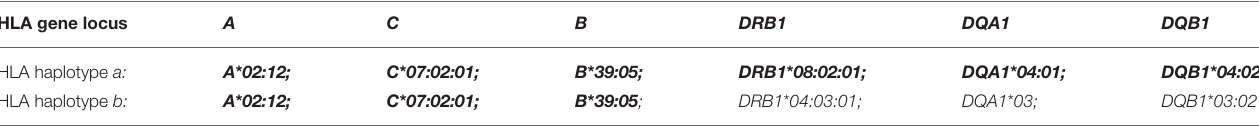
TABLE 1 | Two HLA haplotypes (i.e., combinations of particular alleles at the HLA gene loci in the HLA genetic complex on a given chromosome 6) found in some Rapanui. HLA gene locus A C B DRB1 DQA1